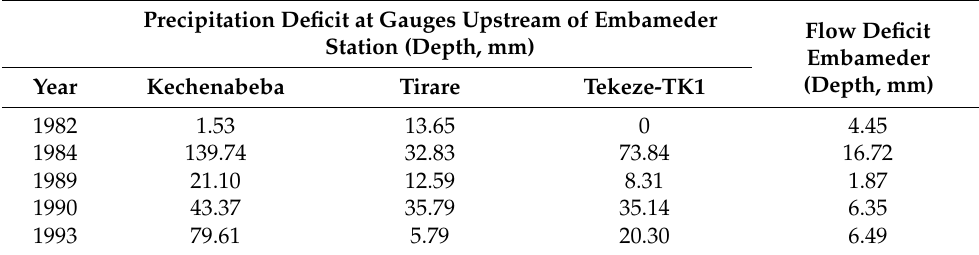
Table 3. Years with precipitation and streamflow deficit for